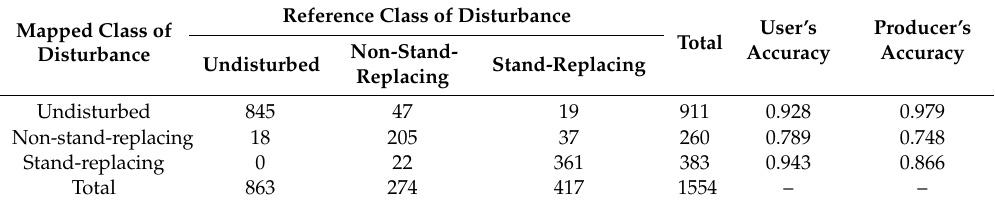
Table 4. The error matrix of LTS-derived classes of disturbance for the entire study area.